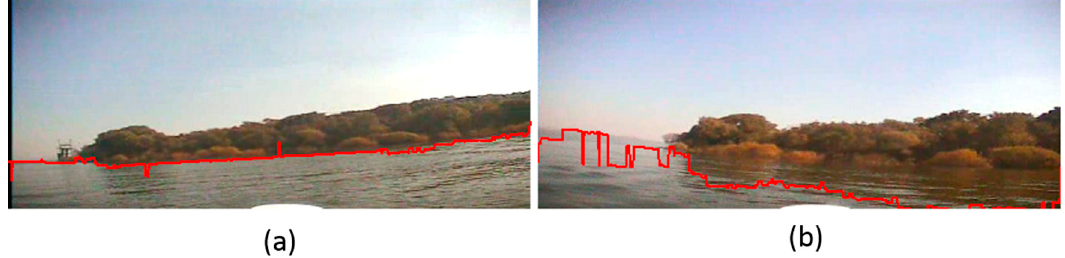
Figure 24. Waterline detection with current edge detection using the same images as Figures 17a and 19 a used to test our method in this paper. ( a ) The waterline detection using the same image as Figure 17a; ( b ) The waterline detection using the same image as Figure 19a.